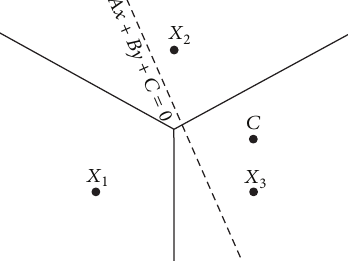
Figure1:Anyhyperplanecanseparateatmostonepairwiseadjacent